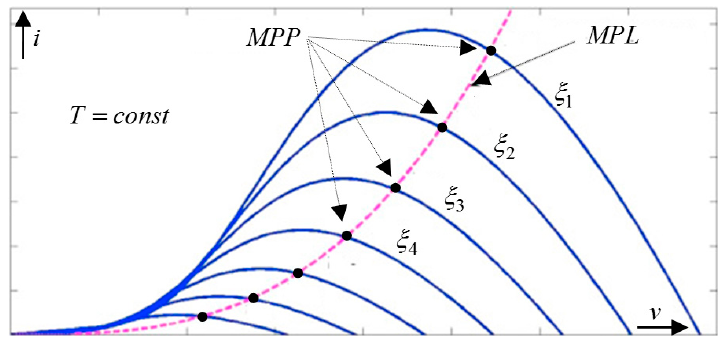
Figure 2. Electrical side REG characteristics for different values of energy producing variable and corresponding MPL.